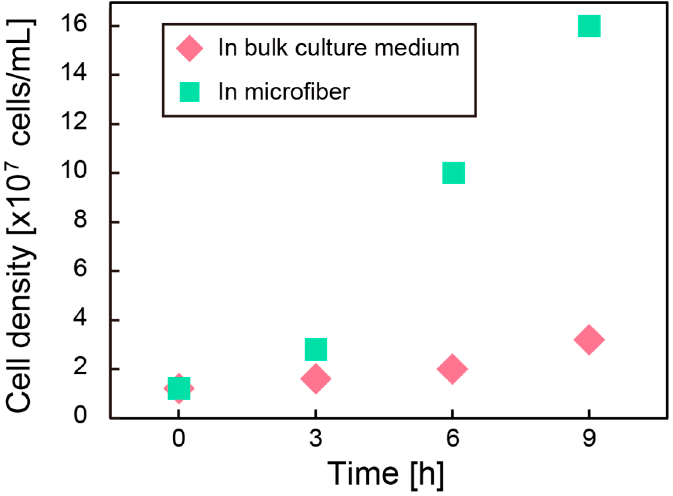
Figure 5. Cell density of C. glutamicum as a function of culture time. The measurements were conducted every 3 h for both conditions.